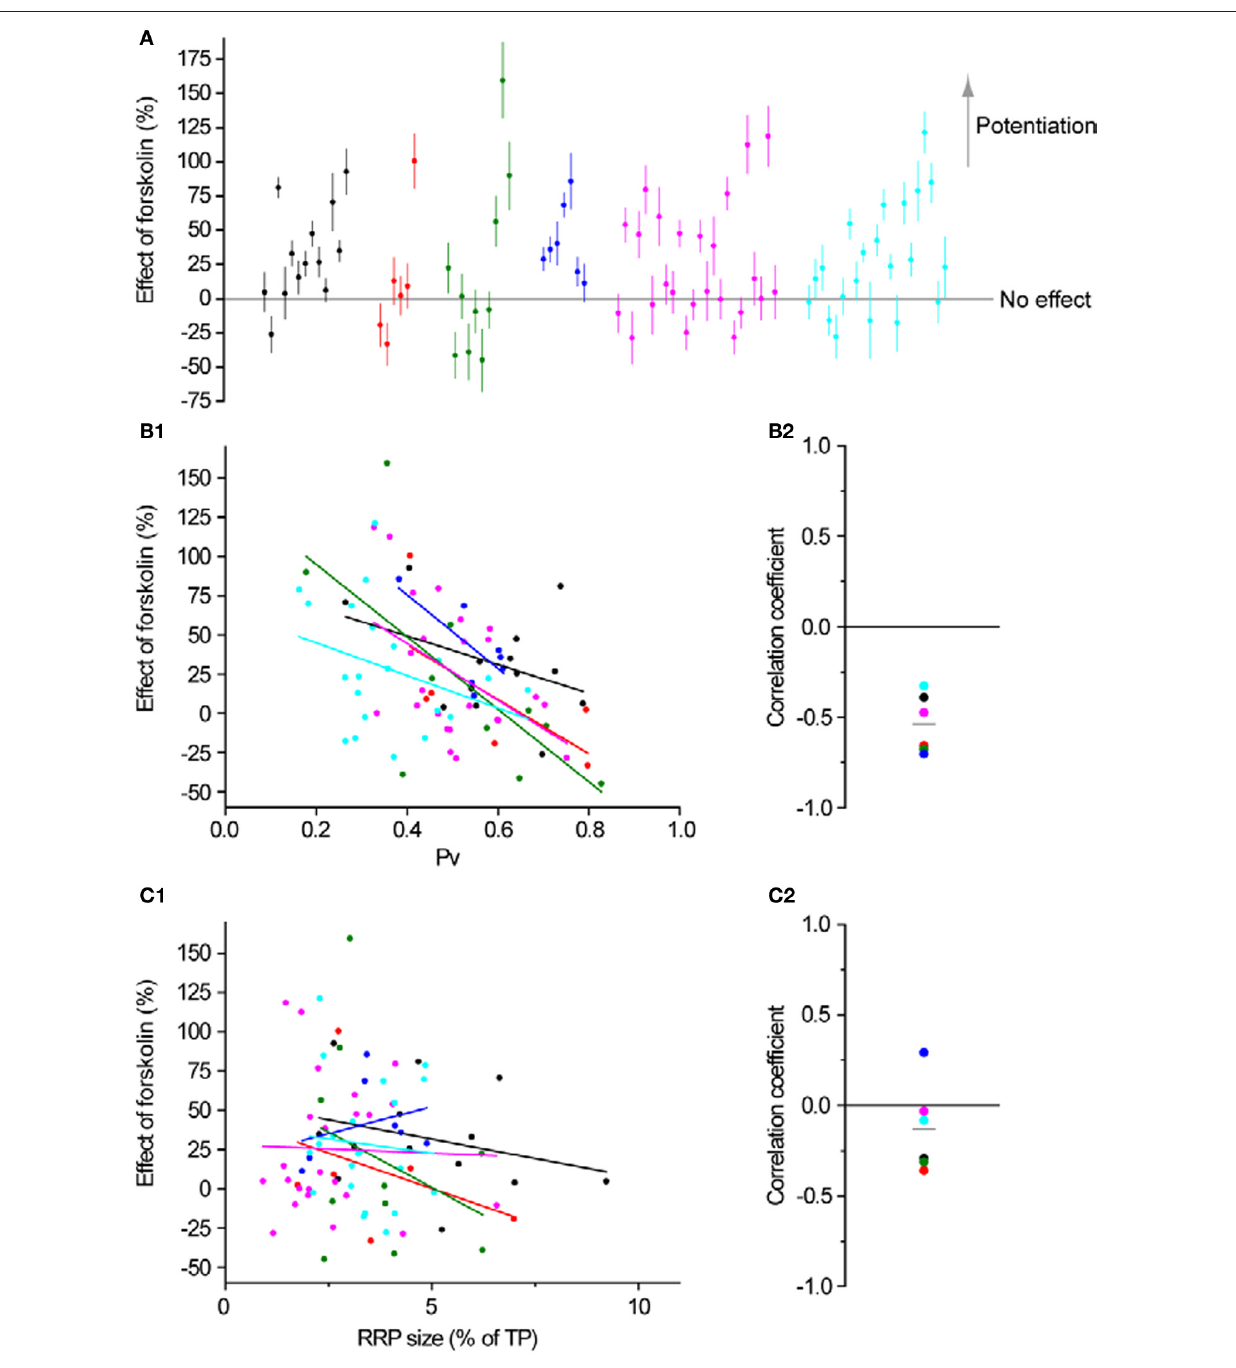
correlation between the effect of forskolin and Pv (one-sample two-tailed t -test against null hypothesis μ = 0 for Pearson correlation coefficients, P = 0 . 0004, t -value = − 8.17). Each dot represents the value of the correlation coefficient for 1 experiment, with colors consistent with the rest of the figure. The gray line represents the average correlation coefficient across experiments. (C1,C2) Effect of forskolin is independent of RRP size. Coloring and symbols are analogous to (B1) and (B2) . Correlation coefficients of the effect of forskolin with RRP size for